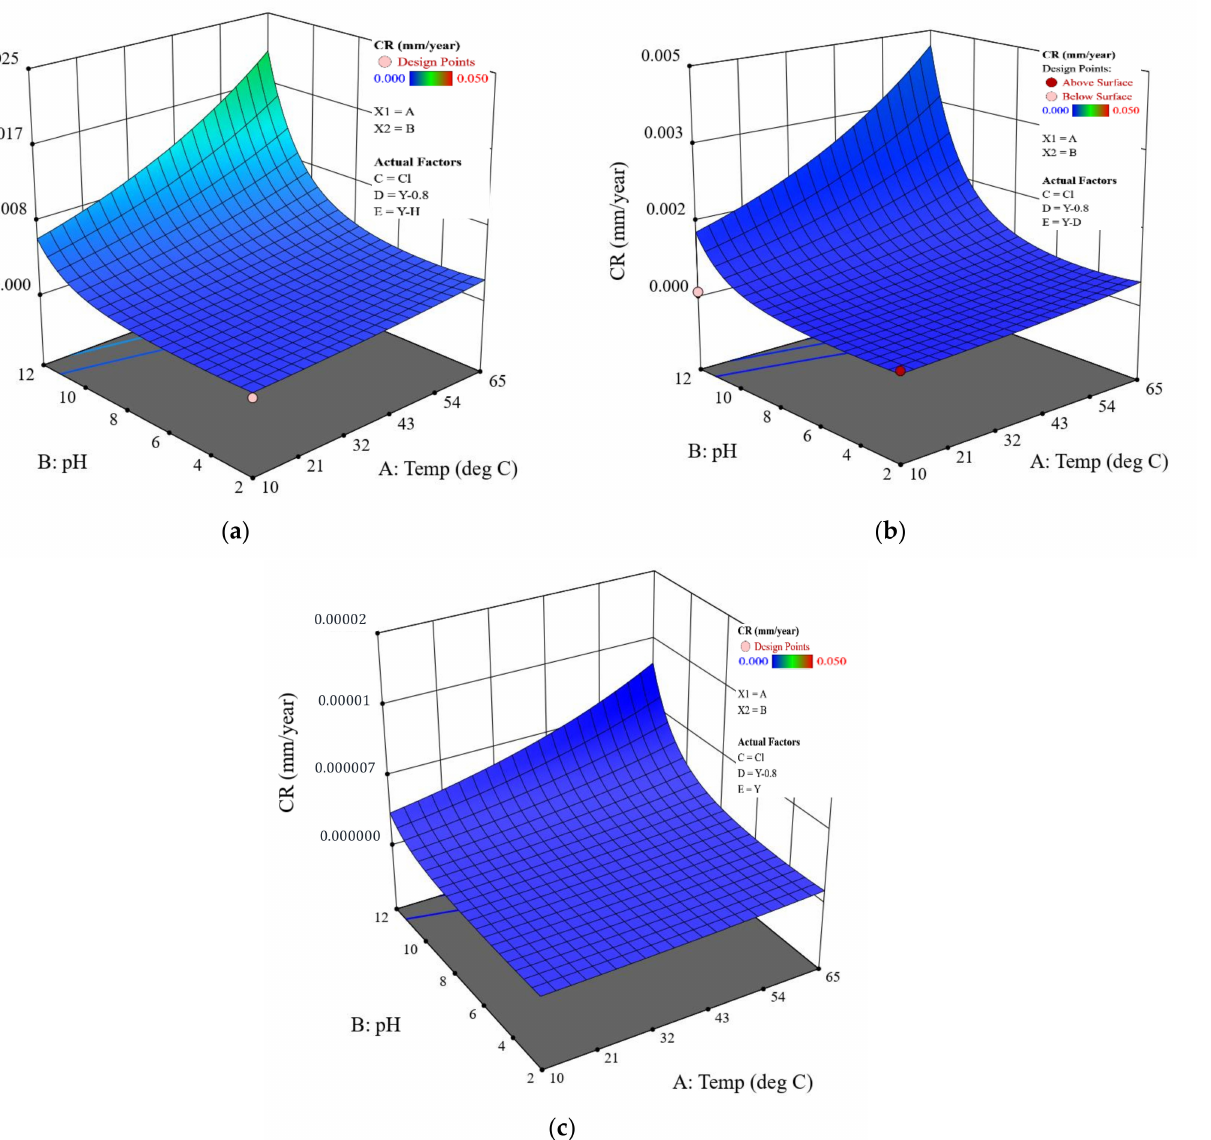
Figure 7. CR predicted by the model for the coated samples with different scenarios: ( a ) coating with a holiday, ( b ) coating with a dent, and ( c ) intact coating. The CP is fixed at − 0.8 V , and the salt is sodium